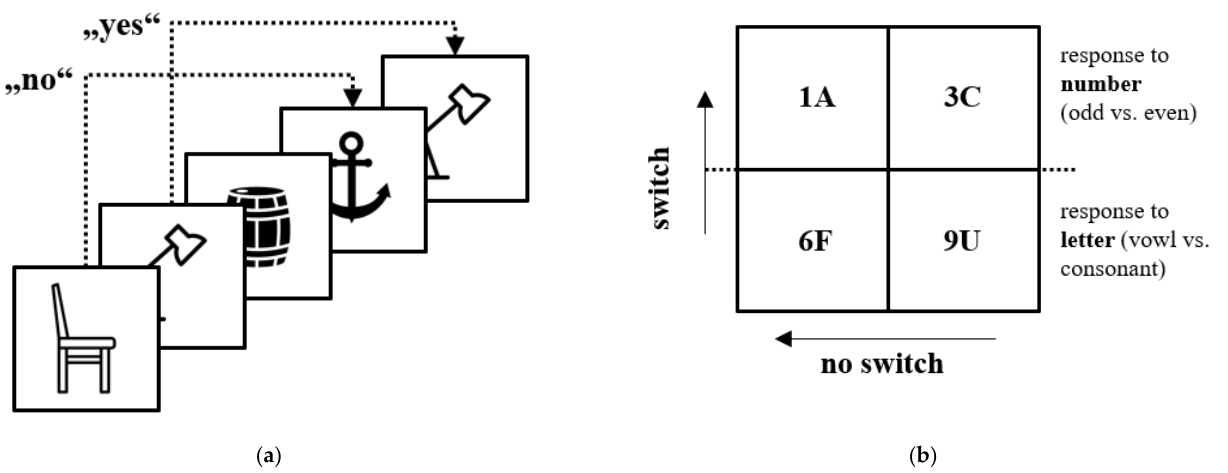
Figure 1. Stimulus presentation for the n-back task ( a ) and number-letter task ( b ).